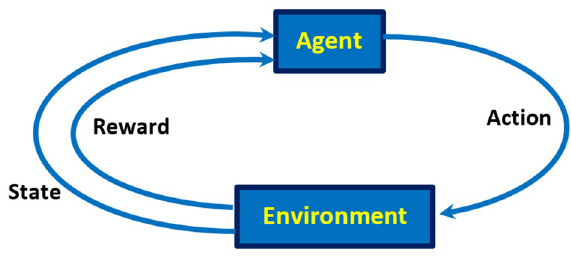
Figure 2. Agent’s performance in the